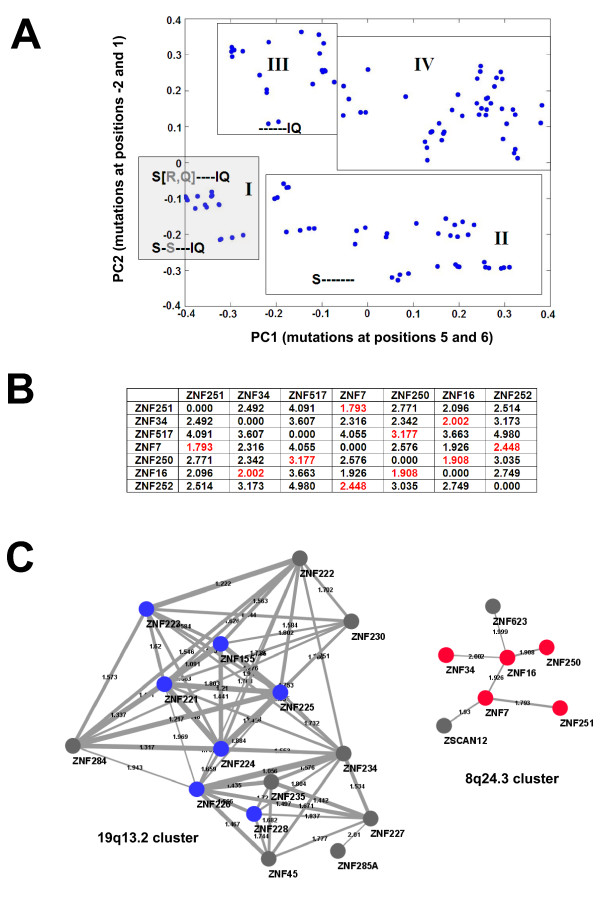
Evaluation of the conservation of the C2H2 ZNF DNA binding domains. (A) Principal component analysis of ZNF domains for conservation based on the 8-amino acid region from -2 to 6 with respect to the start of the α-helix of each finger (see text). Included are all individual fingers from the 8q24.3 ZNF proteins and their mouse and rat orthologs. The plot shows the first (PC1) against the second (PC2) principal component representing the variation in position 5 and 6 or -2 and 1, respectively. Negative values are indicative of lower variability and thus higher conservation. Plot areas that contain the same or similar 8-residue regions are boxed. Conserved amino acids are highlighted in single letter code at respective positions. Dashes indicate non-conserved residues. Additional file 7 details all peptides and their values/coordinates based on the boxed areas. (B) Pairwise ZNF matrix similarities between the 8q24.3 ZNF locus members (see text). Numbers in red indicate lowest values, i.e. highest similarities of each ZNF gene. (C) Detail of a paralog network founded on pairwise ZNF sequence similarities between all human C2H2 ZNF genes (see text). Nodes represent the individual genes (labeled by name), the edges describe their similarity. The thickness of the edges is proportional to the similarity and the value is given as label. A decrease in the value means an increase in similarity. Shown are the isolated 8q24.3 and 19q13.2 clusters of the network with 8q24.3 ZNF member nodes in red, and nodes of 19q13.2 members included in Figure 2 in blue. Network restricted to similarity values ≤ 2.01.